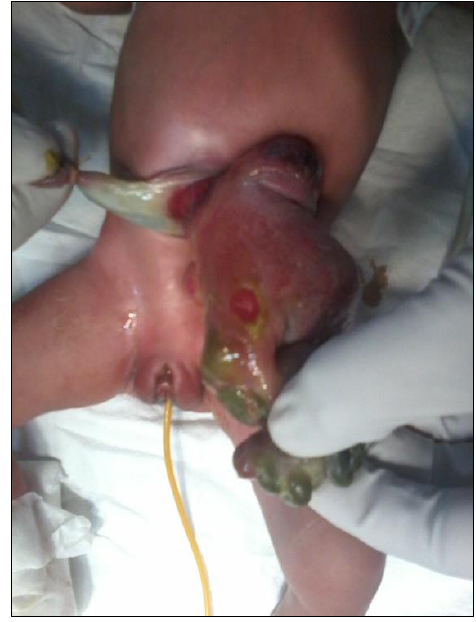
Figure 1: Left sided gastroschisis with intestinal